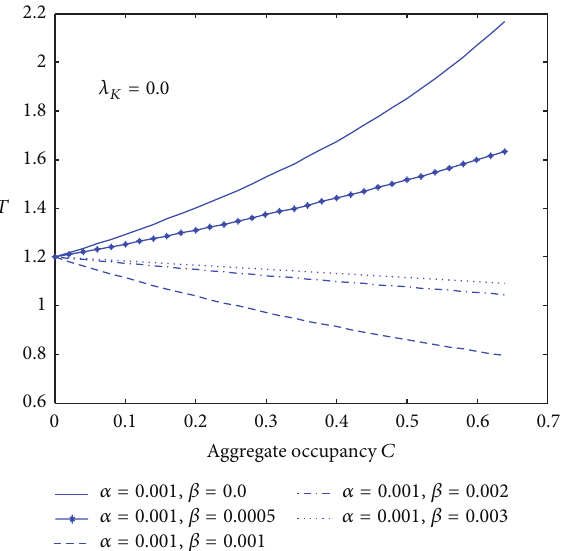
Figure 6: The change curve of the macroscopic inner friction coefficient with aggregate occupancy for different normal softness = 0.0 𝛽 of interface ( 𝜆 𝐾